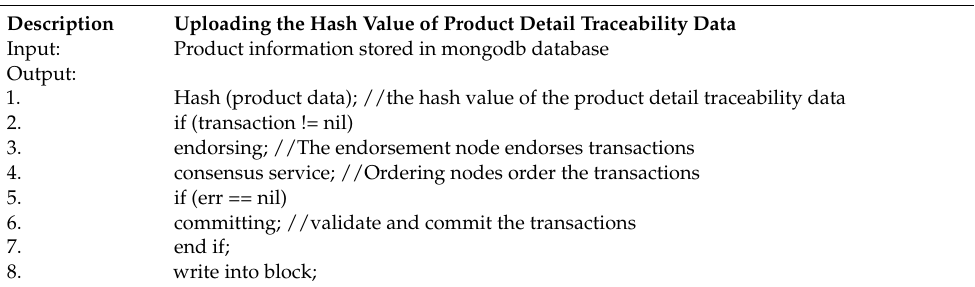
Algorithm 2. Uploading the hash value of the product detail traceability data.